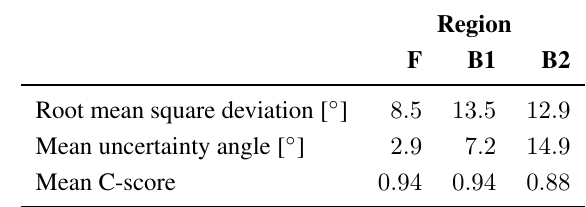
Table 2. Root mean square deviation, uncertainty angle, and C-score calculated for three regions: Fram Strait (F) on 14 March 2011 (Figure 5), Beaufort Sea (B1) on the same date (map not shown), and Beaufort Sea (B2) on 14 November 2004 (Figure